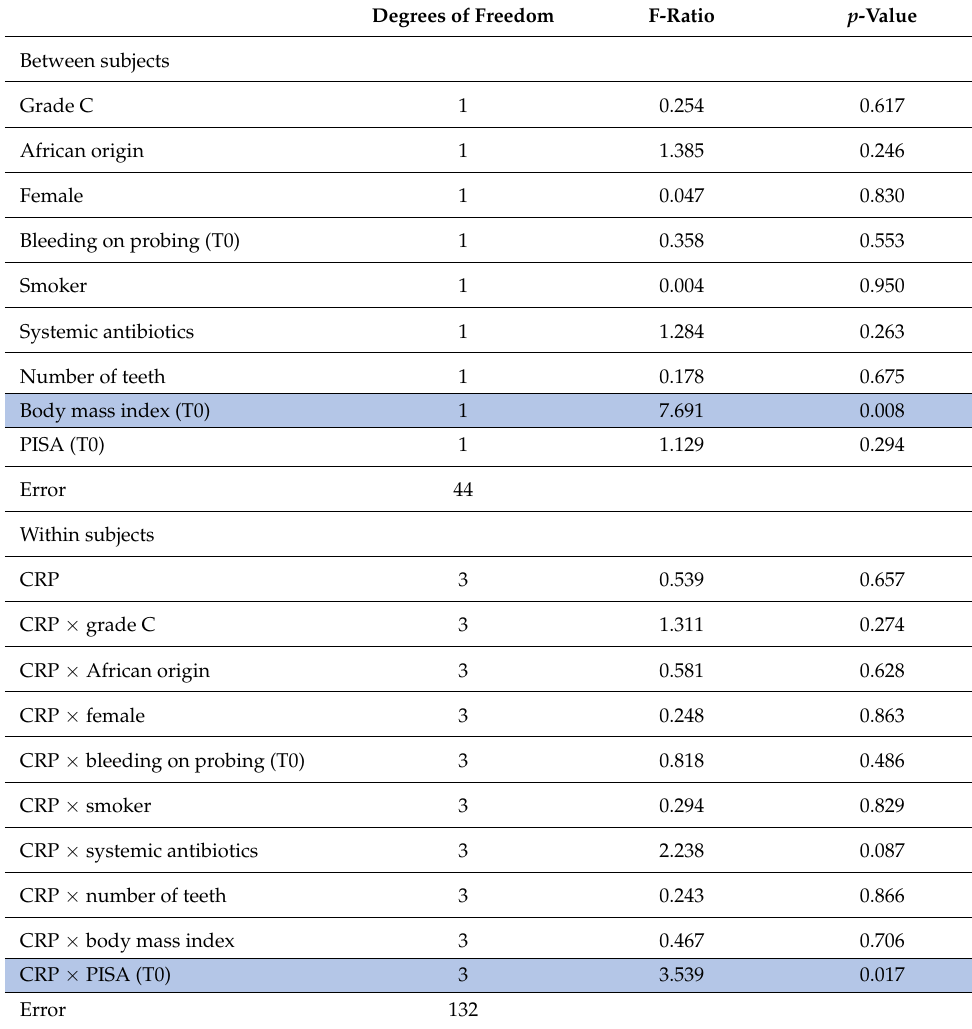
Table 5. Repeated measures analysis of variance of log-transformed C-reactive protein